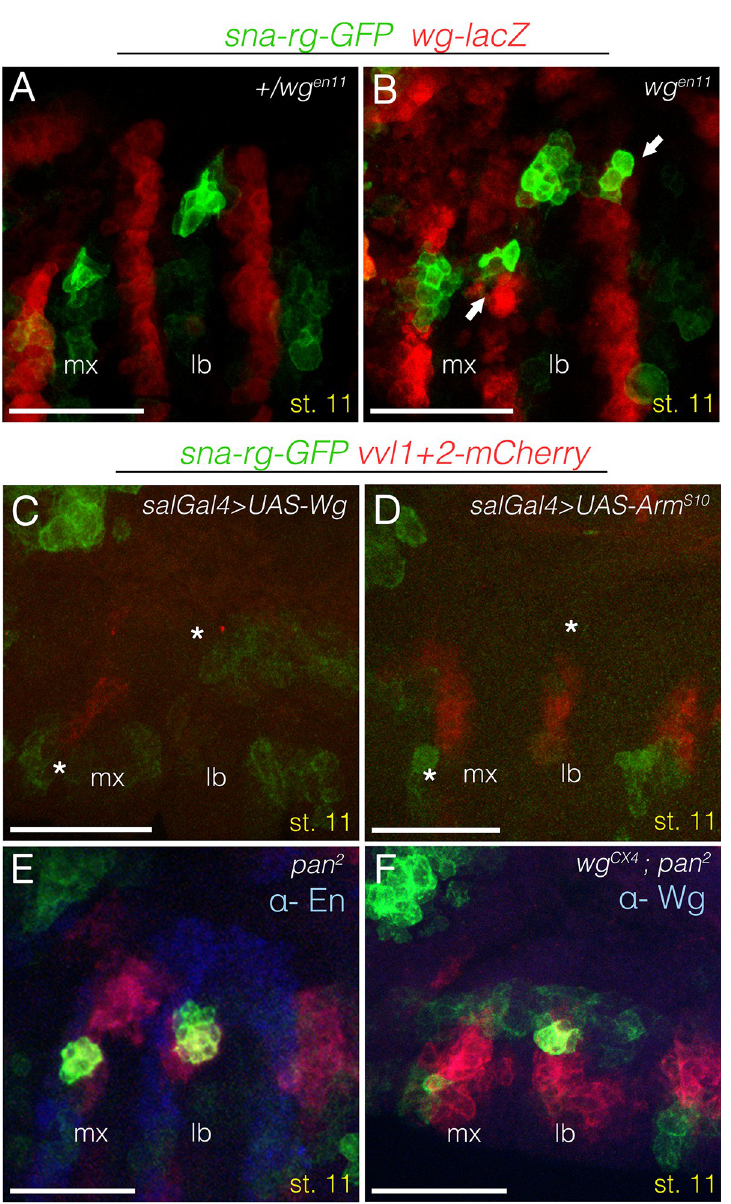
Fig 2. Wnt pathway requirement for gland specification. (A-F) st11 gland primordia double labelled with sna-rg- GFP in green, and in red the wg expressing cells with a wg en11 reporter line (A-B) or the vvl expressing cells with a vvl1 +2-mCherry reporter line (C-F). (A) Control sna-rg-GFP wg en11 -lacZ/+ embryo. sna-rg labels specifically the CA and the PG cells invaginating at the anterior end of the maxillary and labial segments respectively. (B) In wg en11 homozygous mutants, ectopic patches of sna-rg expression appear on the wingless expressing cells (arrows) in the maxilla and labium at the same dorso-ventral positions as the endogenous ones. (C) Wg ectopic expression driven in the maxillary and labial segments with spalt-Gal4 results in the downregulation of sna-rg expression (asterisks). Downregulation of vvl1+2 cephalic expression is also observed. (D) Ectopic expression of activated Armadillo results in sna-rg downregulation (asterisks). (E) pan 2 (dTCF) null mutants present normal sna-rg expression and Engrailed (blue) stripe expression is maintained. (F) wg CX4 pan 2 double mutant embryos do not present ectopic endocrine primordia. Embryo in panel F is also stained with anti-Wg to recognise the homozygous wg mutants. Scale bar 50 μ m.